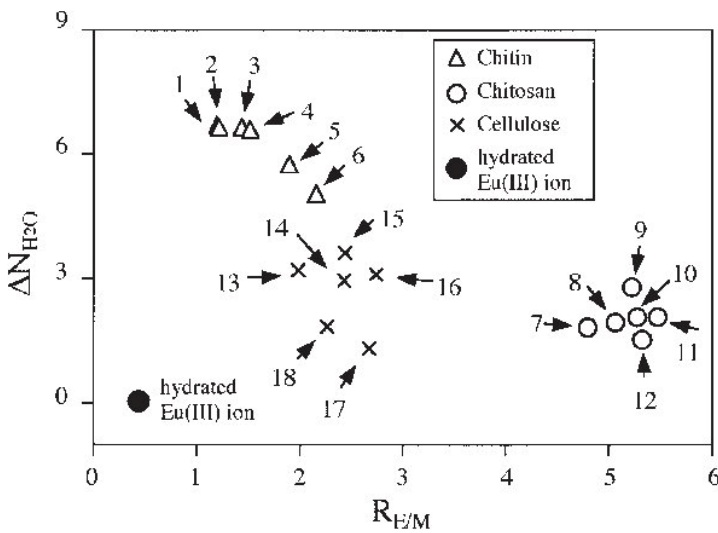
Figure 14. From [64]. pH between 6.5 and 7.9; highest pH means least replacement of H 2 O by polysaccharide. Accordingly, Eu will stick much better to arthropods or lichens than to plant leaves, influencing rates of photooxidation of embedded substrates (sugars and amino acids) as well as increasing leaching rates of Eu 2+ .